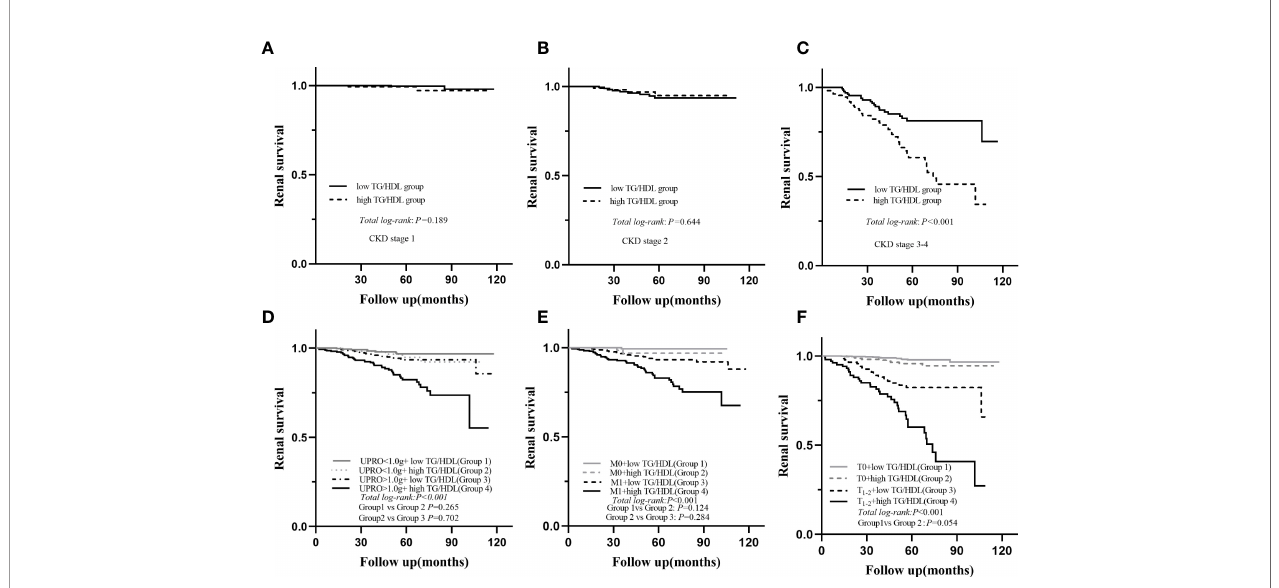
FIGURE 3 | Subgroup Kaplan-Meier analysis for endpoint of ESRD; eGFR (A – C) , UPRO (D) , M (E) , T (F) ; eGFR, estimated glomerular fi ltration rate; UPRO, 24 h urine protein; M, mesangial proliferation; T, tubular atrophy/interstitial fi brosis.